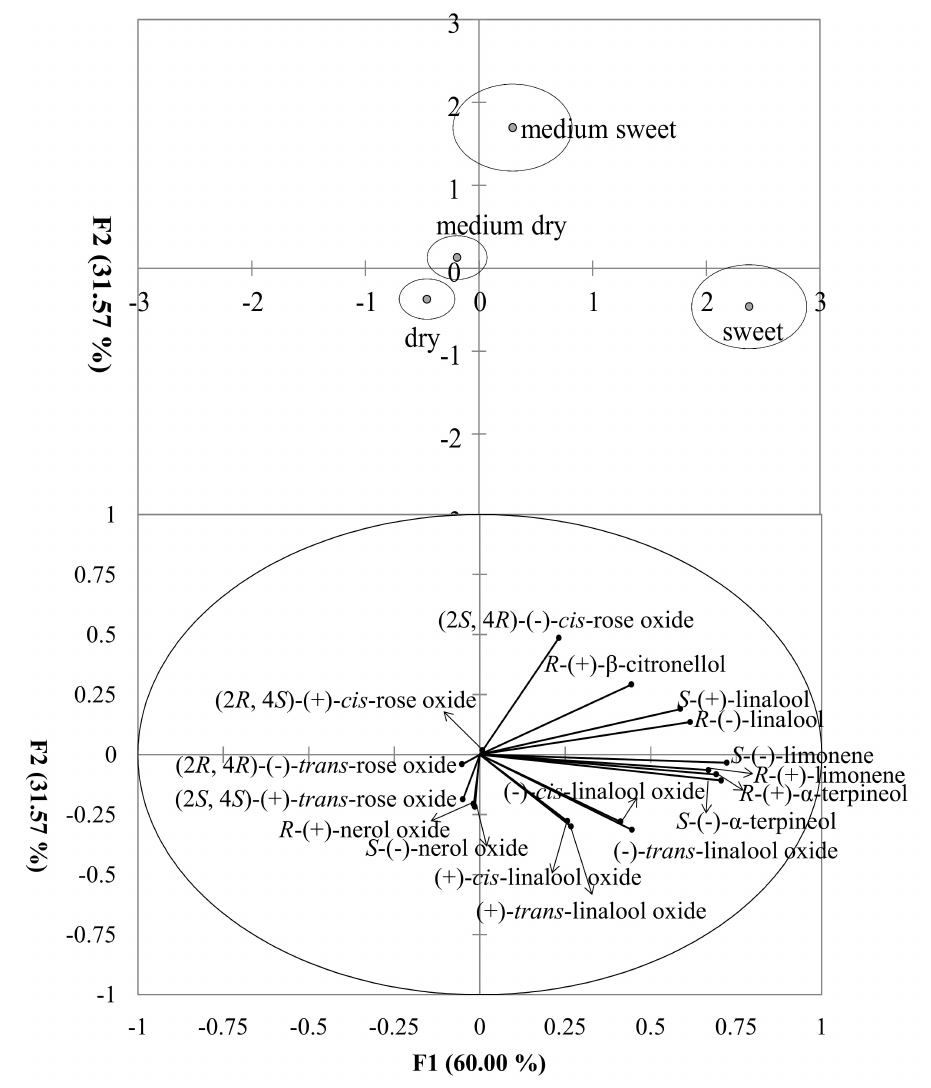
Figure 3. Discriminant plot of wine style on concentration of monoterpene isomers. Upper panel, Wines styles scores were represented by centroids surrounded by 95% confident regions. Bottom panel, all compound vectors were